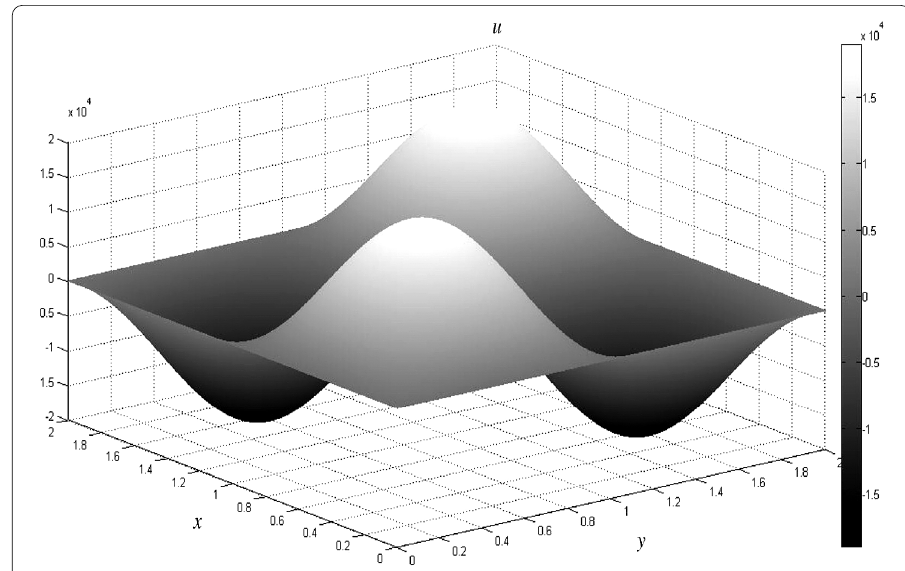
Figure 3 FVE solution with the first-order accuracy when t = 2